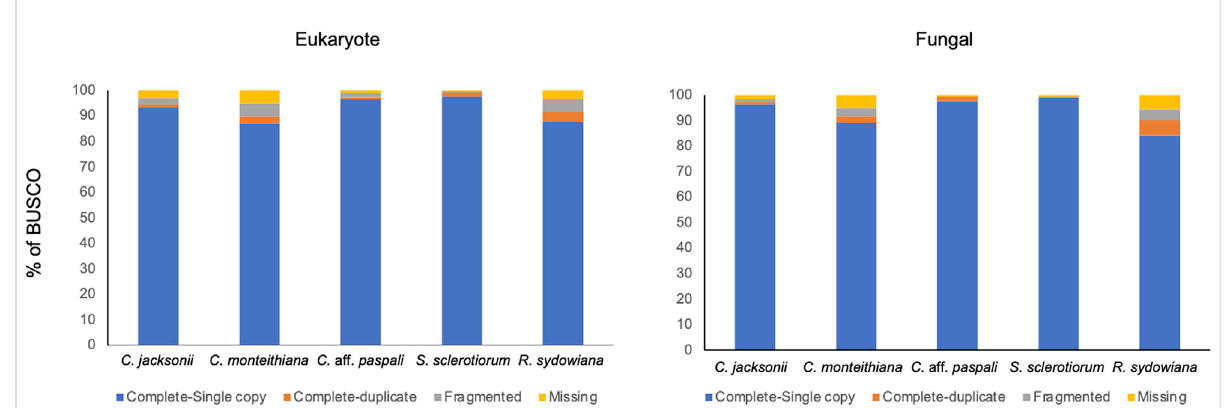
FIGURE 3 Benchmarking Universal Single Copy Orthologs (BUSCO) analysis of gene models using the eukaryote obd10 ( n = 255; species = 70) and the fungal obd10 ( n = 758; species = 549) BUSCOs. Gene models generated in this paper from the Augustus pipeline were used for the C . aff. paspali (H3 isolate). Published gene models were used for C. jacksonii (LWC-10), C. monteithiana (DRR09), and R. sydowiana (CBS115975), and S. sclerotiorum (1980 UF-70).